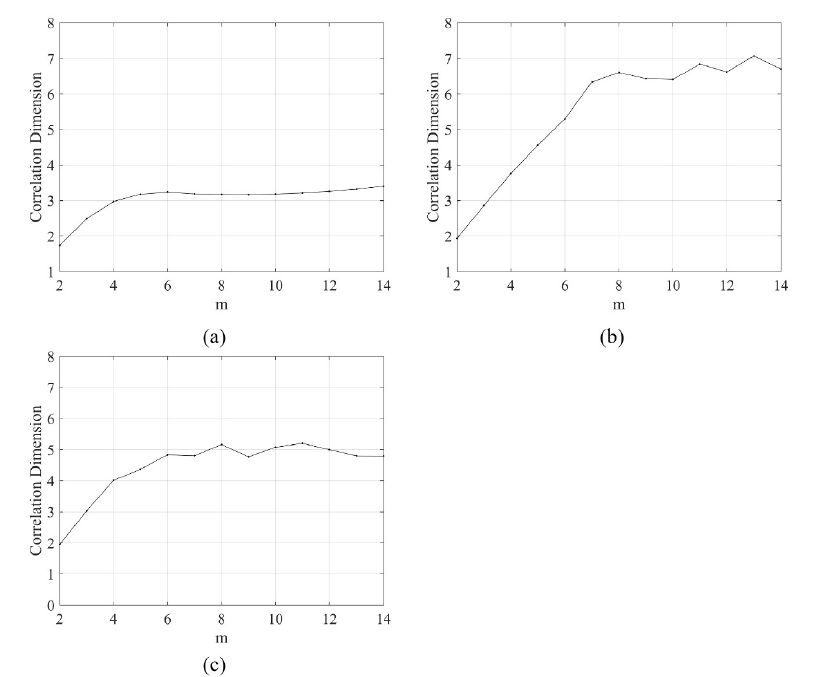
Figure 4. The curves of m and correlation dimension D for the EDH time series at three different timescales: ( a ) hourly, ( b ) daily, and ( c ) monthly.